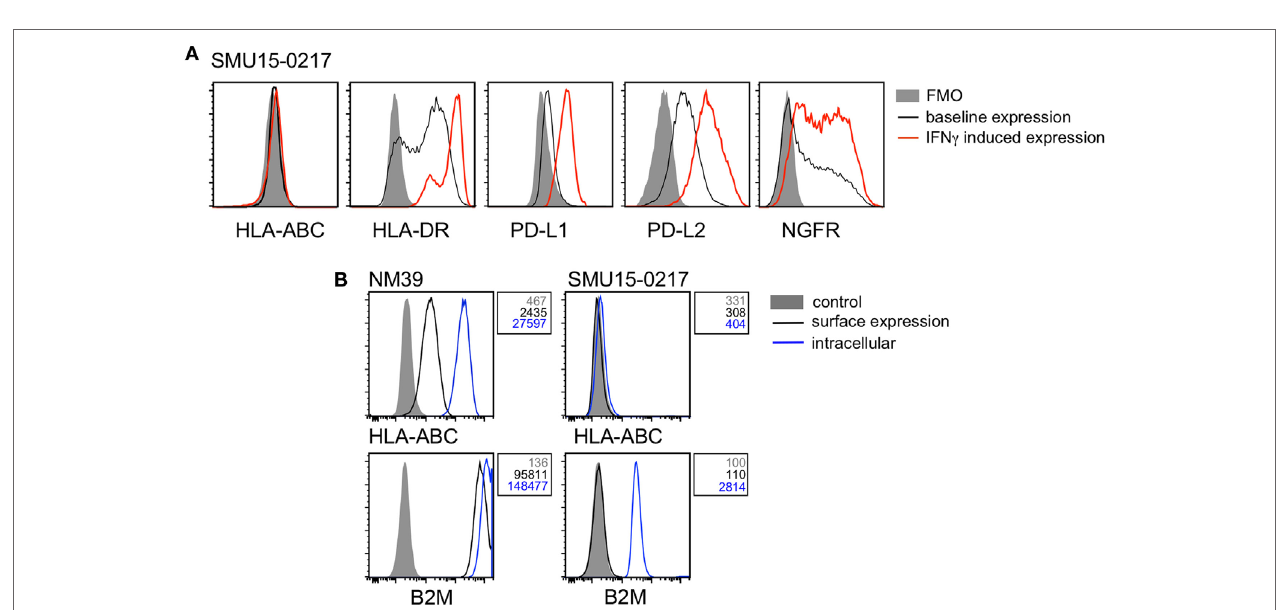
FigUre 5 | Analysis of β -2-microglobulin (B2M) expression in the SMU15-0217 cell line. (a) Representative histograms of cell surface expression of HLA-ABC, HLA-DR, PD-L1, PD-L2, and nerve growth factor receptor (NGFR) on SMU15-0217 cells. Baseline expression is shown in black, interferon- γ (IFN γ )-induced expression in red, and fluorescence minus one (FMO) controls as shaded histograms. (B) Expression of HLA-ABC and B2M on the cell surface (black) and intracellularly (blue) in NM39 and SMU15-0217 cells. Shaded histograms represent the mock stained control and mean fluorescence intensity values are shown next to the histograms. NM39 cells were used as a positive control.